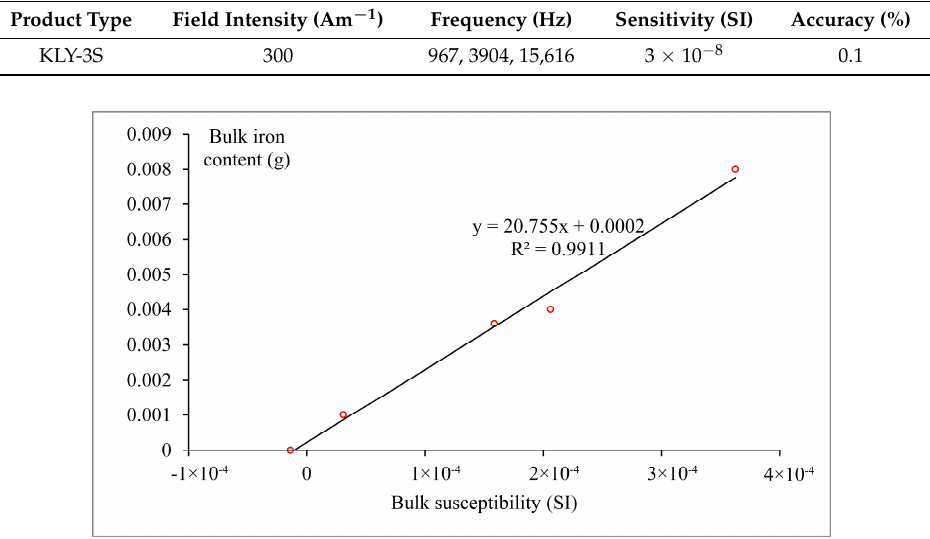
Figure 2. Relationship between iron content and susceptibility. The linear fitting relation is: y= 20.755x + 0.0002 with R 2 = 0.9911.